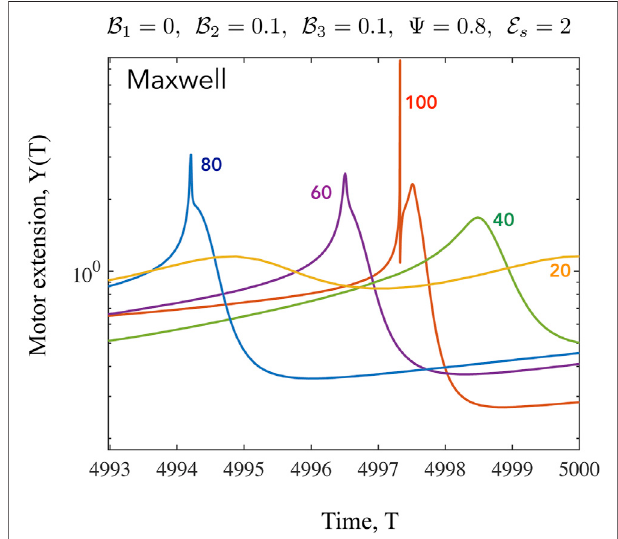
FIGURE 9 | Time series of the mean motor extension Y for the Maxwell case shown for β =20,40,60,80,100. Here we focus on the shape of the function close to the point where Y = Y max . When β to close toits critical value, the oscillations are harmonic as seen from the form of Y ( T ) for β =20. As the value of β increases, the periodic pro fi les becomes highly asymmetric and also develop double maxima and double minima, especially evident for β =100. The high values of Y are associated with very low values of N when very few motors are attached, with these motors extended signi fi cantly.